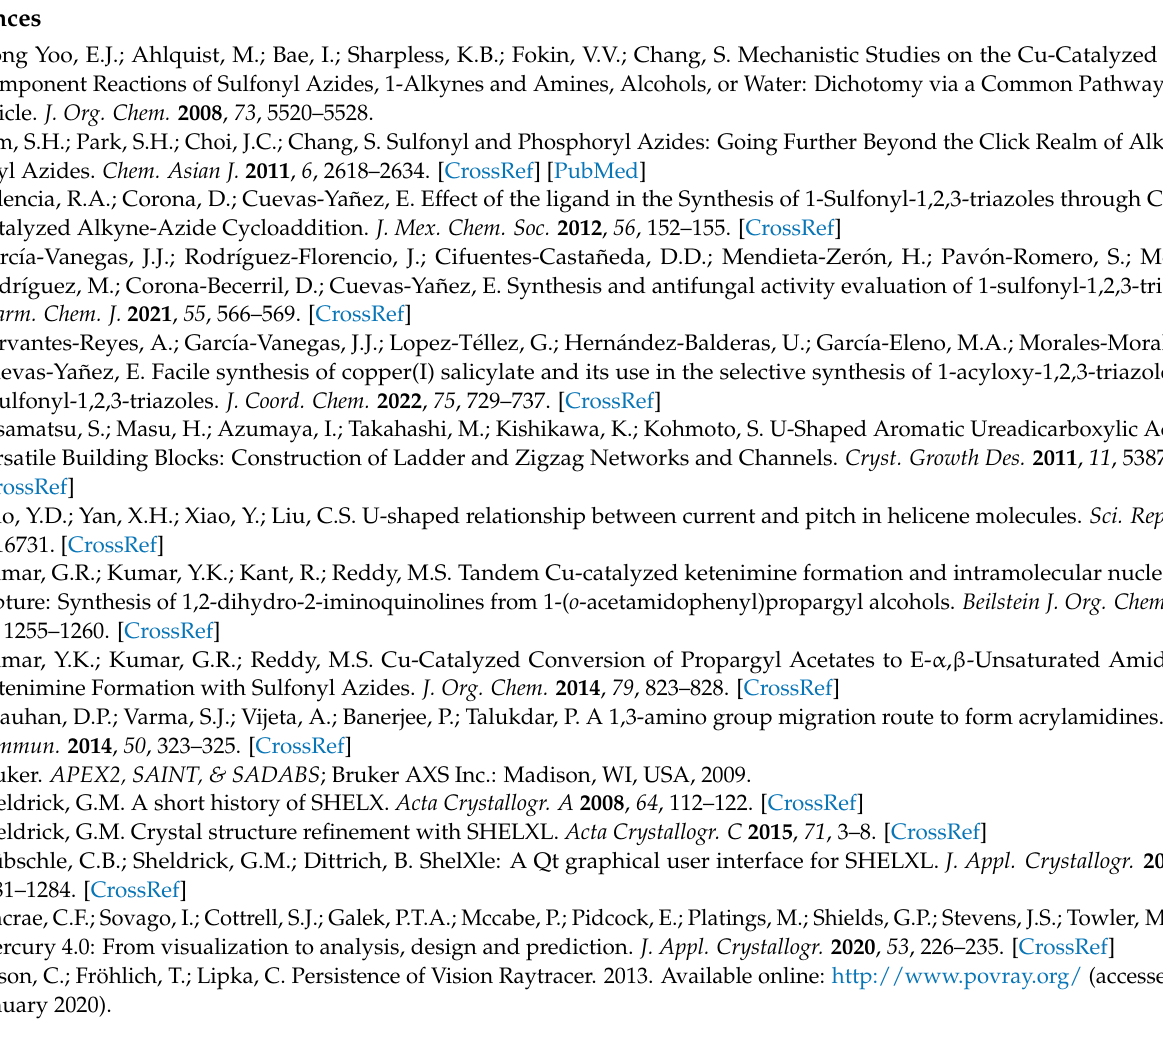
3 . Figure S2. HRESIMS spectrum for imidate 3 . Figure S3. 1 H NMR spectrum for imidate 3 (CDCl 3 , 300 MHz). Figure S4. 13 C{ 1 H} NMR spectrum for imidate 3 (CDCl 3 , 75